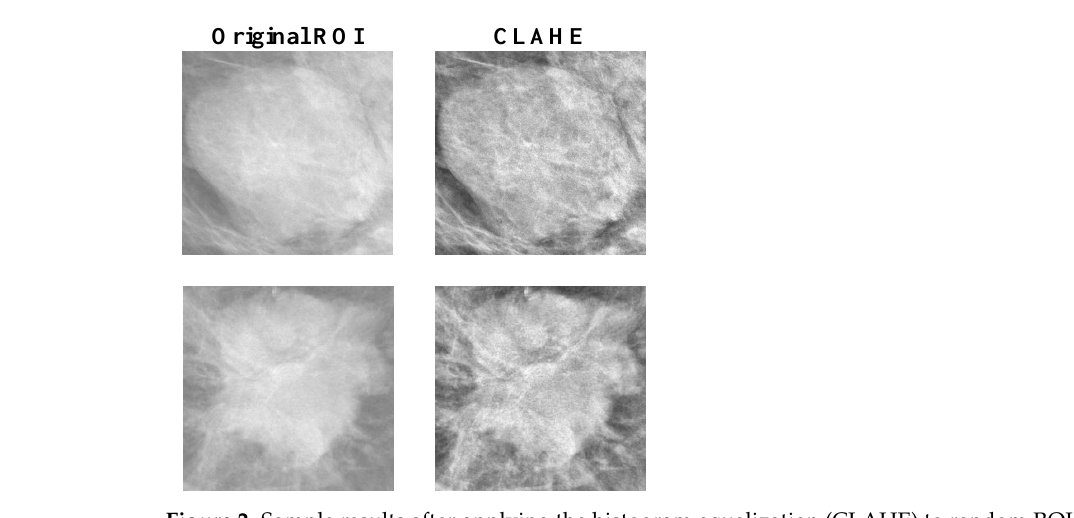
Figure 2. Sample results after applying the histogram equalization (CLAHE) to random ROI images from the datasets.